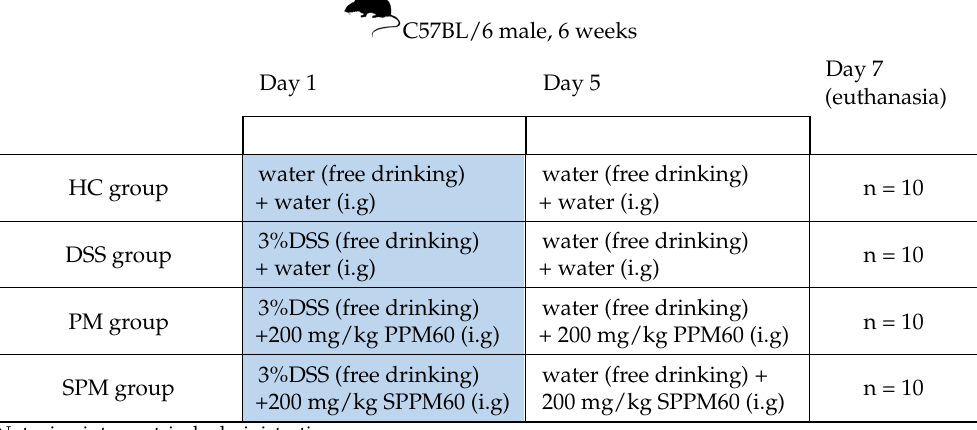
Table 1. Illustration of the experimental treatment of mouse ulcerative colitis models.